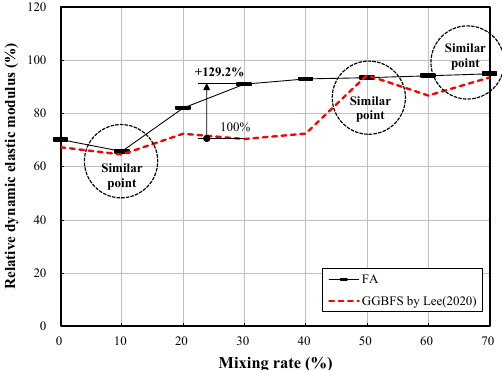
Figure 13. Results of the relative dynamic elasticity modulus of OPC and FA compared with GGBFS as measured by Lee (adapted from [26]) in terms of the mixing rate.